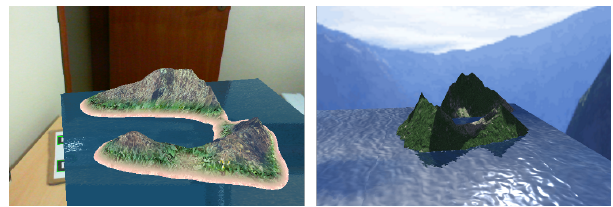
Fig. 8. Example of generated terrain to the left and to the right the visualization of the same terrain in another application.